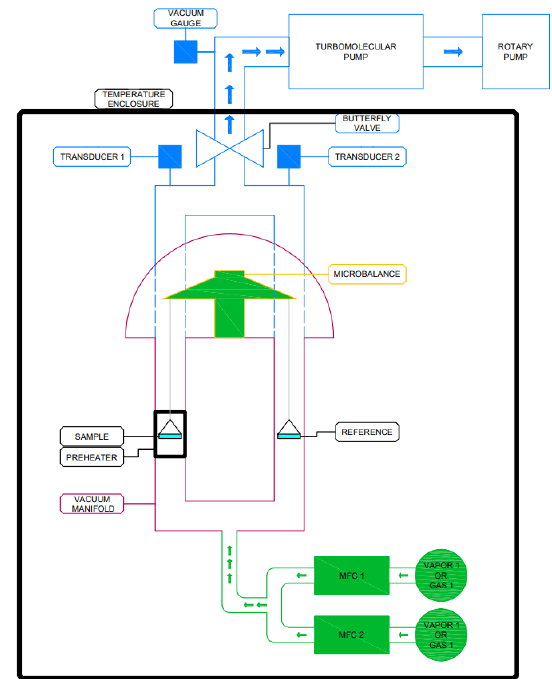
Figure 1. DVS Vacuum Surface Measurement System.